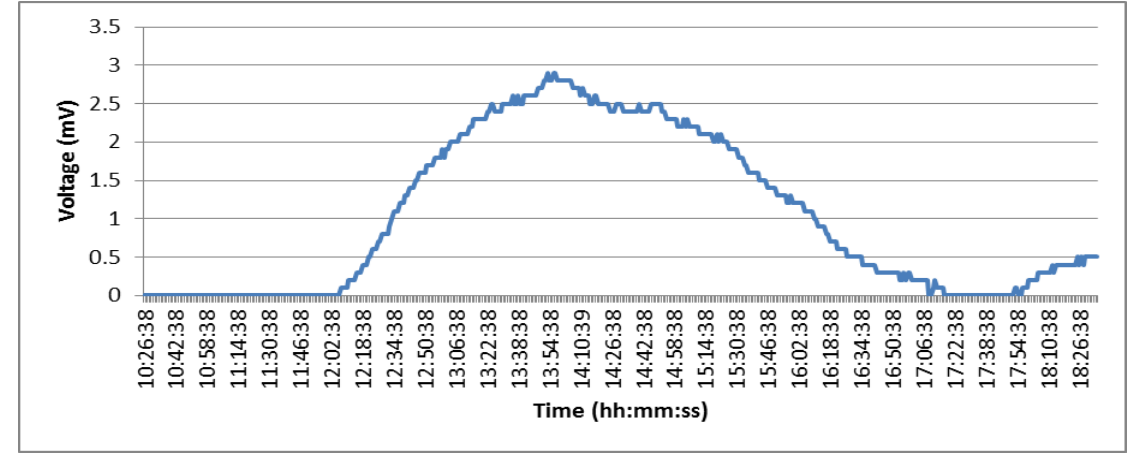
Figure 12. Energy generated by the Peltier cell outside a